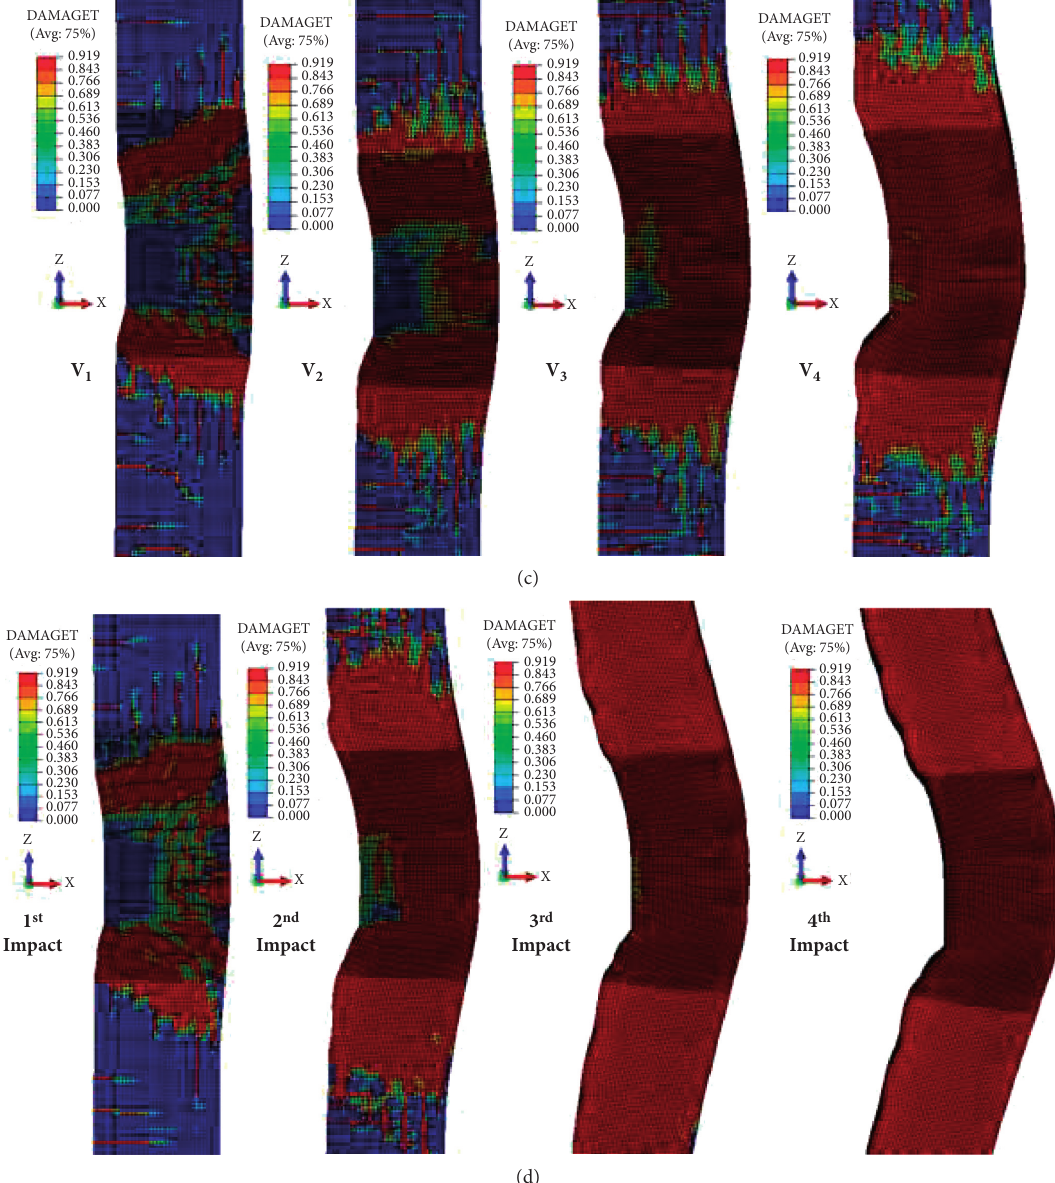
Figure 14: Concrete damage modes of BC-2 at different impact velocities. (a) Compression damage under a single impact. (b) Compression damage under repeated impact. (c) Tensile damage due to single impact. (d) Tensile damage due to repeated